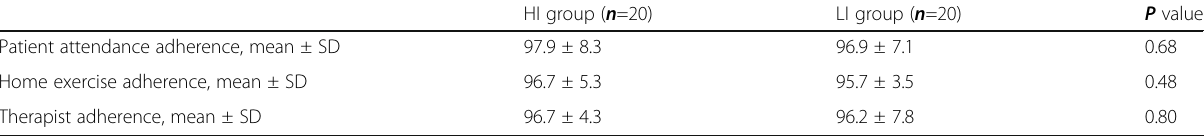
Table 5 Adherence of both the therapist and the patients to the assigned therapy program in both groups HI group ( n